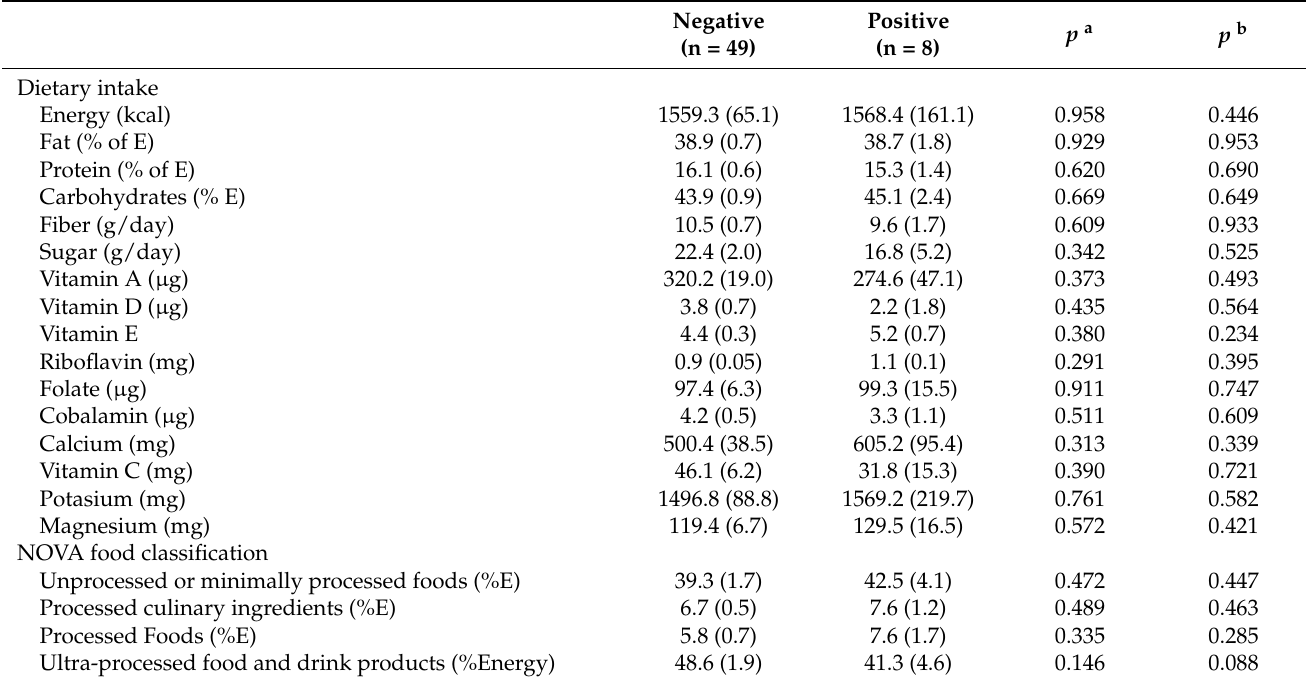
Table 2. Differences in dietary intake by fecal gluten immunogenic peptide detection (negative vs.